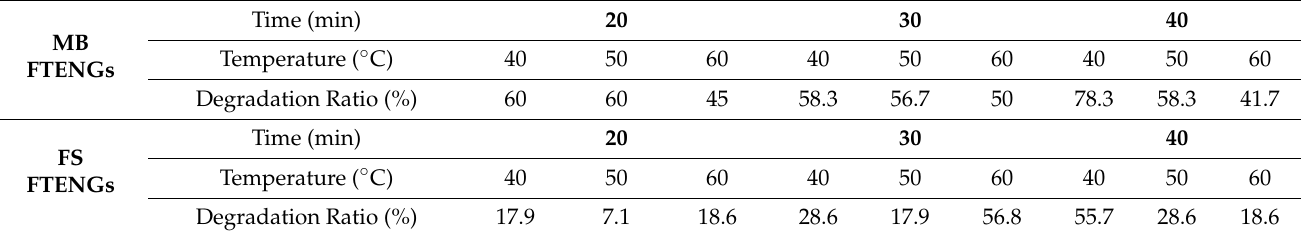
Table 1. The degradation ratio of output voltages of the FTENGs based on the FS fabric and the MB fabric under various washing